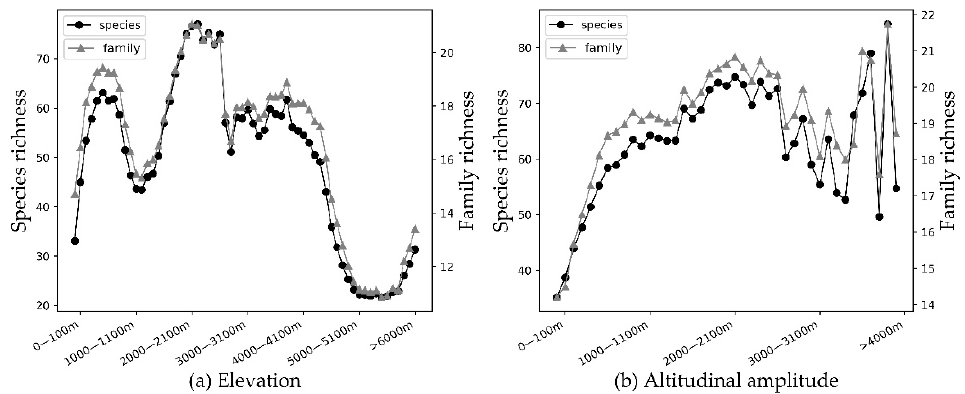
Figure 6. The relationship between average values of terrestrial mammal richness and elevation ( a ), and altitudinal amplitude ( b ).